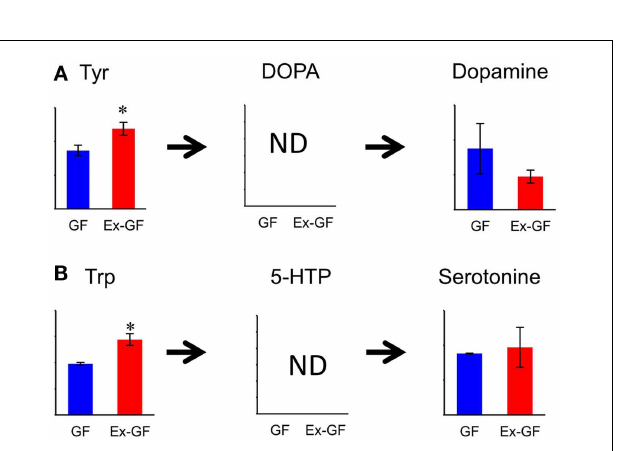
FIGURE 7 | Relative quantitative comparisons of metabolites in the biosynthetic pathway for dopamine (A) and serotonin (B), in the cerebrum of GF mice and Ex-GF mice . Data are represented as mean ± SD. * p < 0.05, *** p < 0.001 (GF vs. Ex-GF).